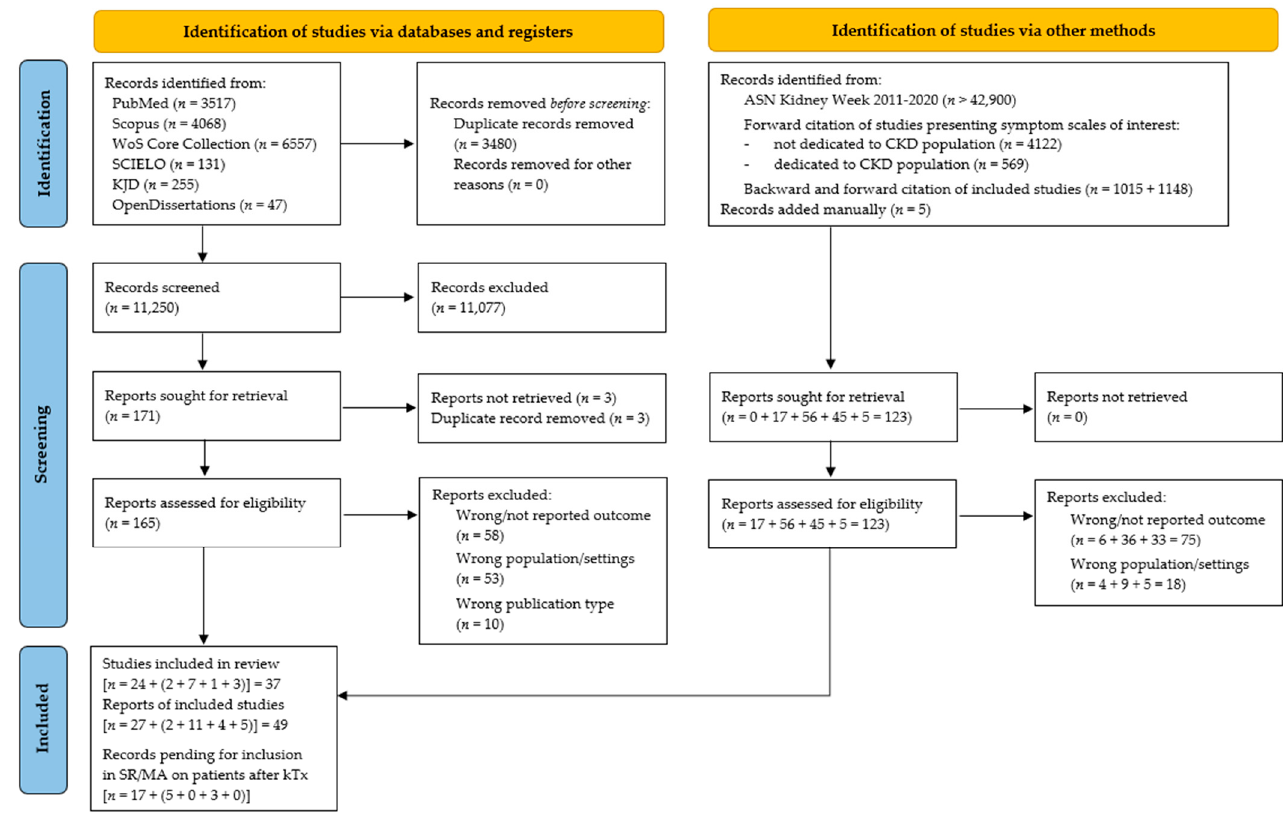
Figure 1. PRISMA 2020 flow diagram.